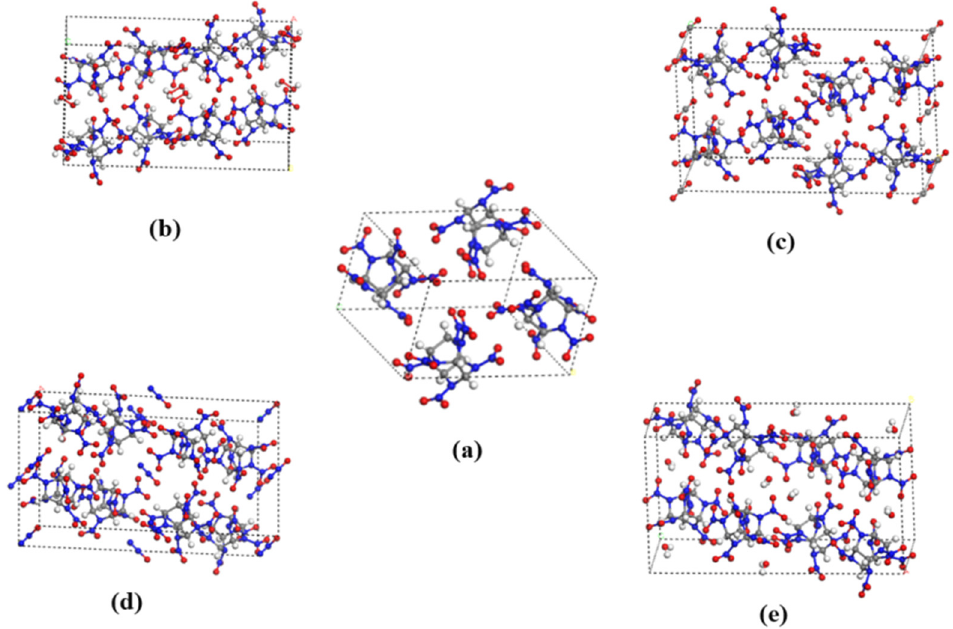
Figure 2. The unit cell: ( a ) CL-20, ( b ) CL-20/H 2 O 2 , ( c ) CL-20/CO 2 , ( d ) CL-20/N 2 O, and ( e ) CL-20/H 2 O. Gray, blue, red, and white spheres stand for carbon, nitrogen, oxygen and hydrogen atoms, respec- tively.